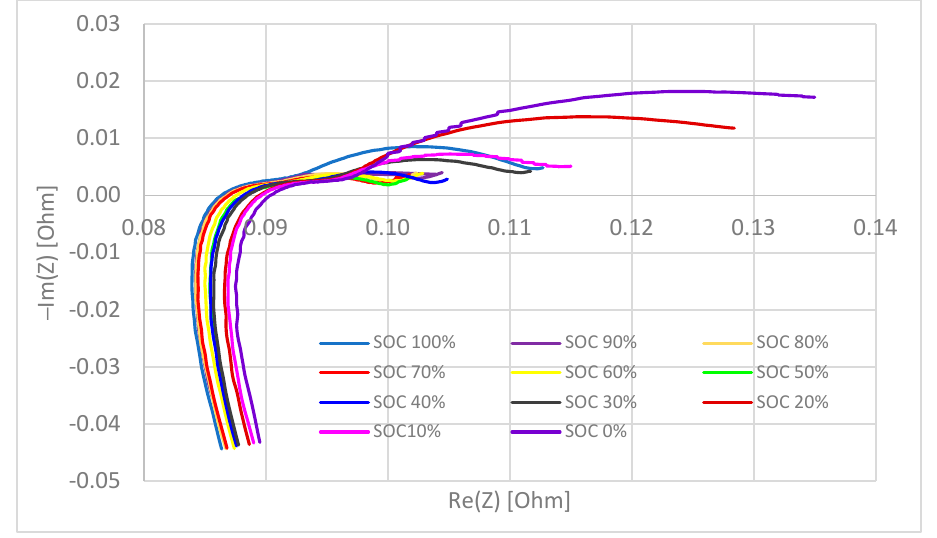
Figure A2. EIS spectrum for A1 cell.